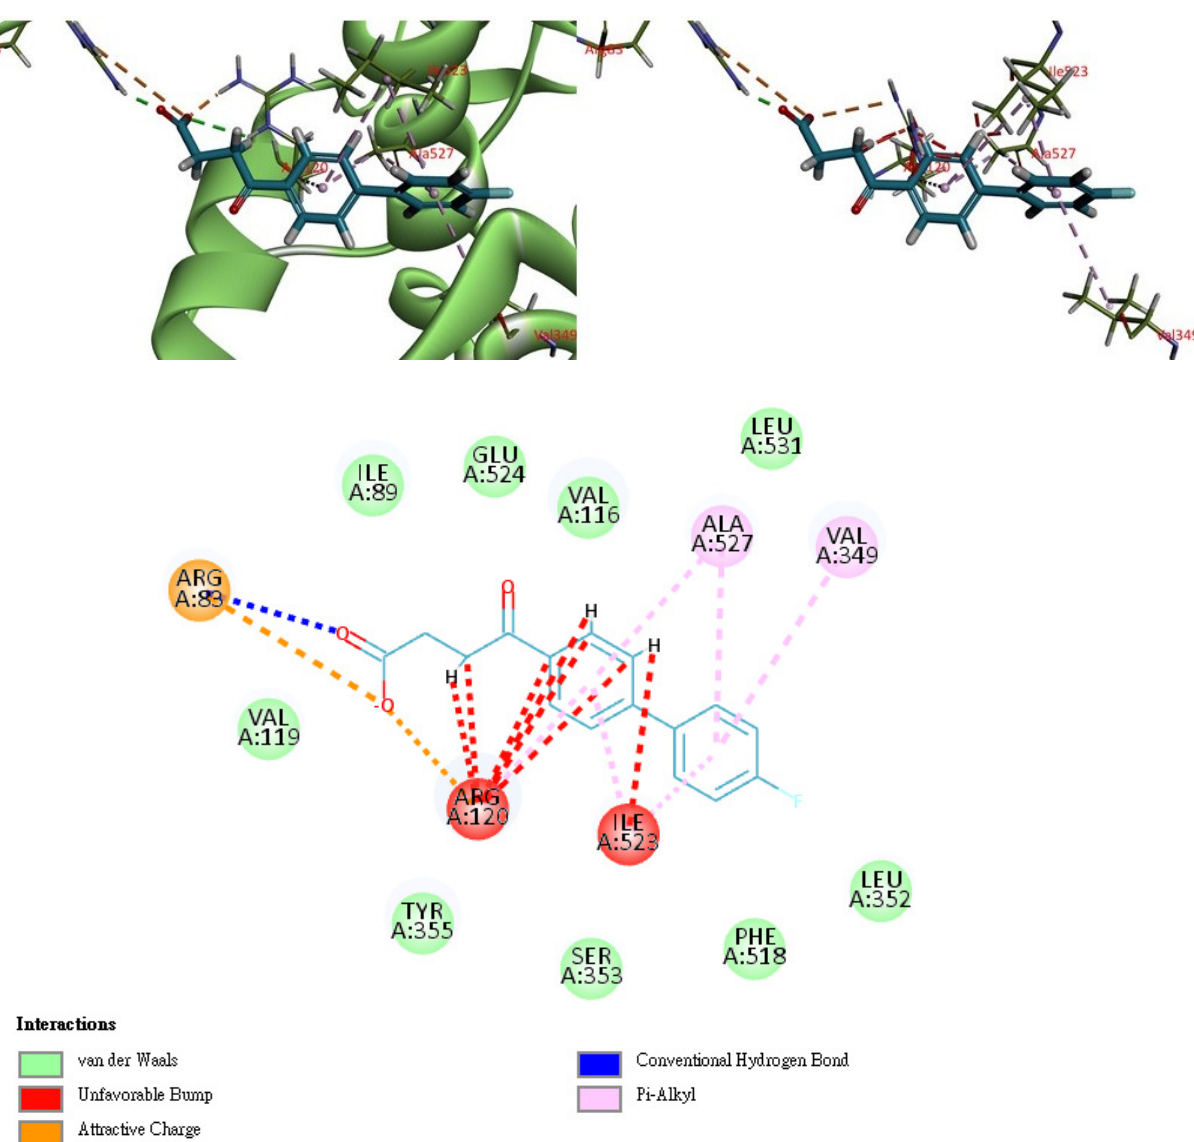
Figure 8. The 3-dimensional and 2-dimensional representations of the interaction of fluoro compound 6a with the active site of COX-1 enzyme (1EQG). The subunits responsible for interacting with compound 6a are labeled in color and the interactions are denoted by the dotted lines.